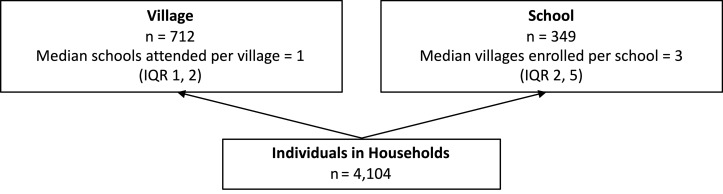
Diagram for the classification model of individuals, villages, and schools.